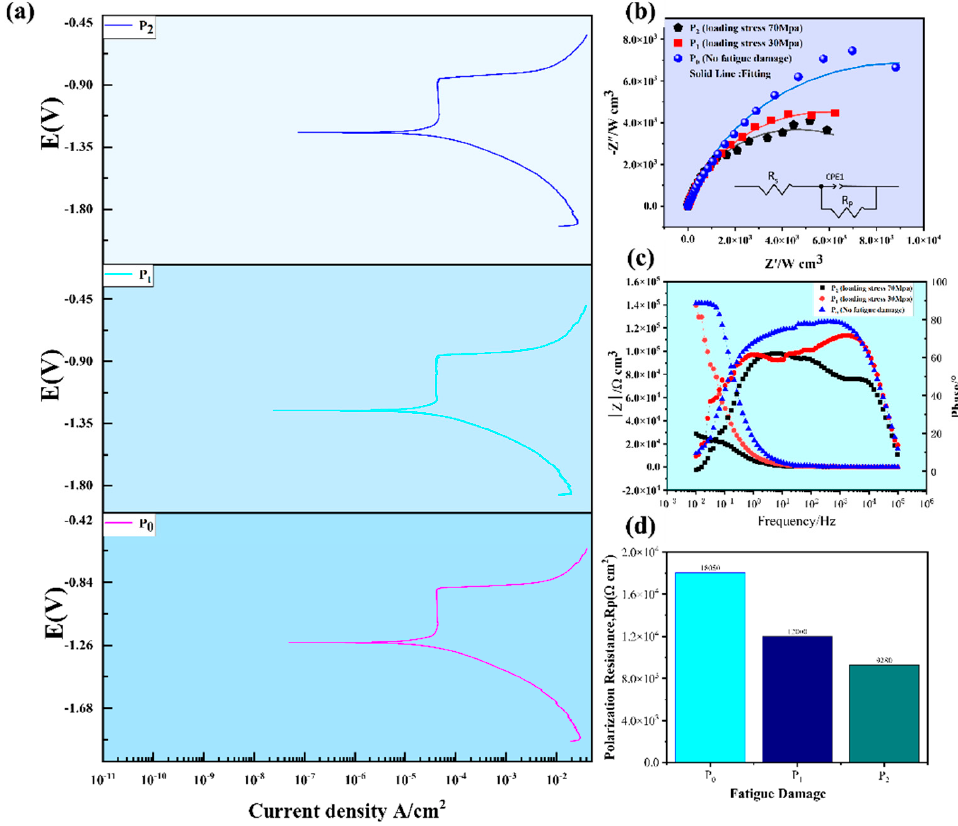
Figure 3. ( a ) Polarization curve, ( b ) Nyquist plot, ( c ) baud diagram, ( d ) Rp is polarization resistance. Table 2. Electrochemical